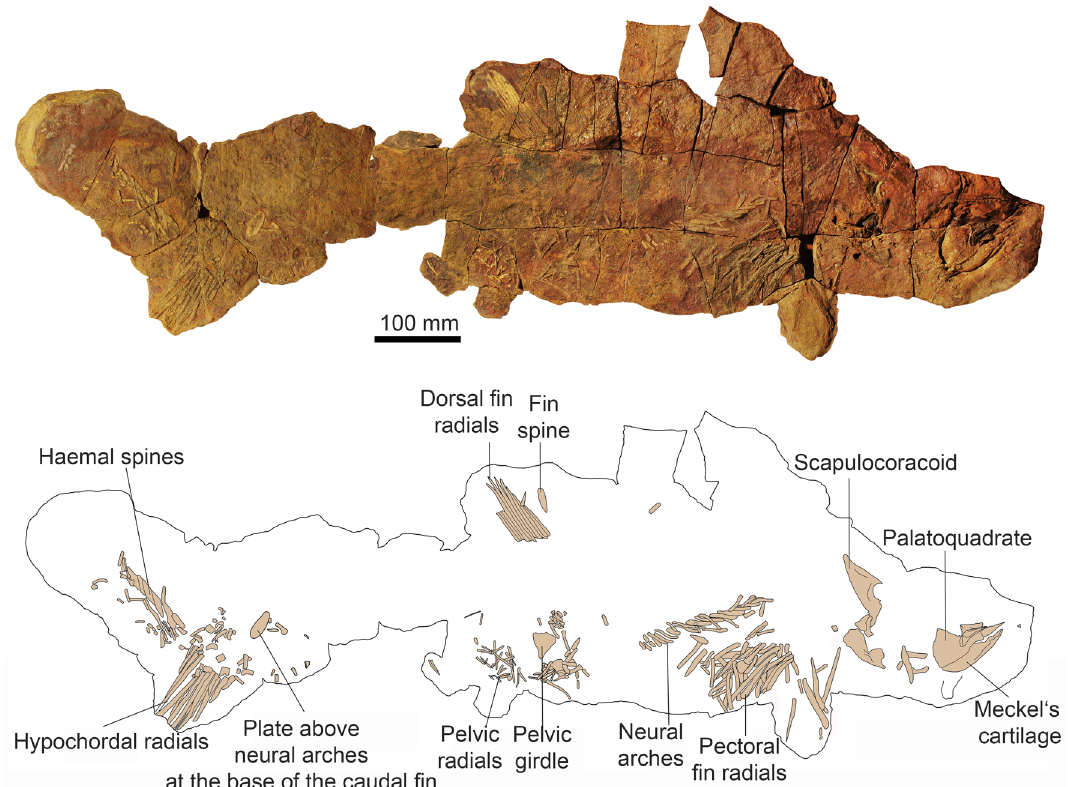
Fig. 2 Photo and drawing of a nearly complete skeleton of Maghriboselache mohamezanei n. gen. et sp., AA.BER.DS.01. The marked fin spine belongs to the posterior